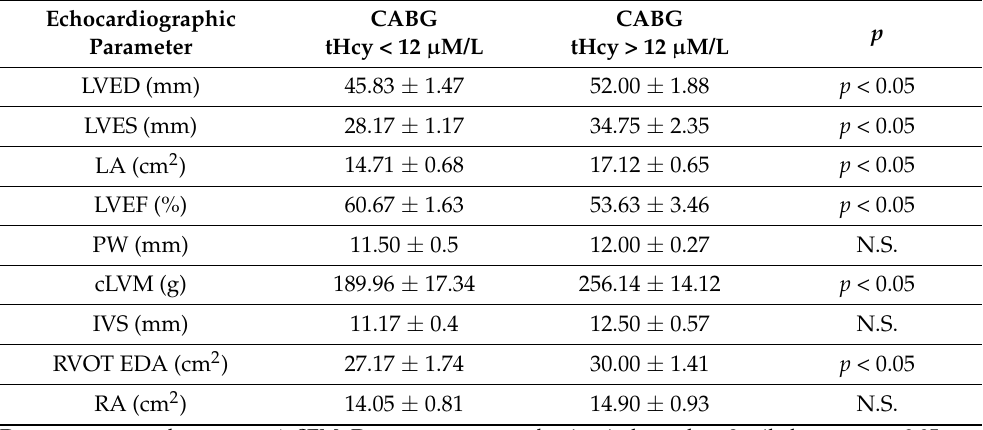
Data are expressed as means ± SEM. Data were compared using independent 2-tailed t -test. p < 0.05 was considered statistically significant. CABG—coronary artery bypass graft surgery; LVED—left-ventricular